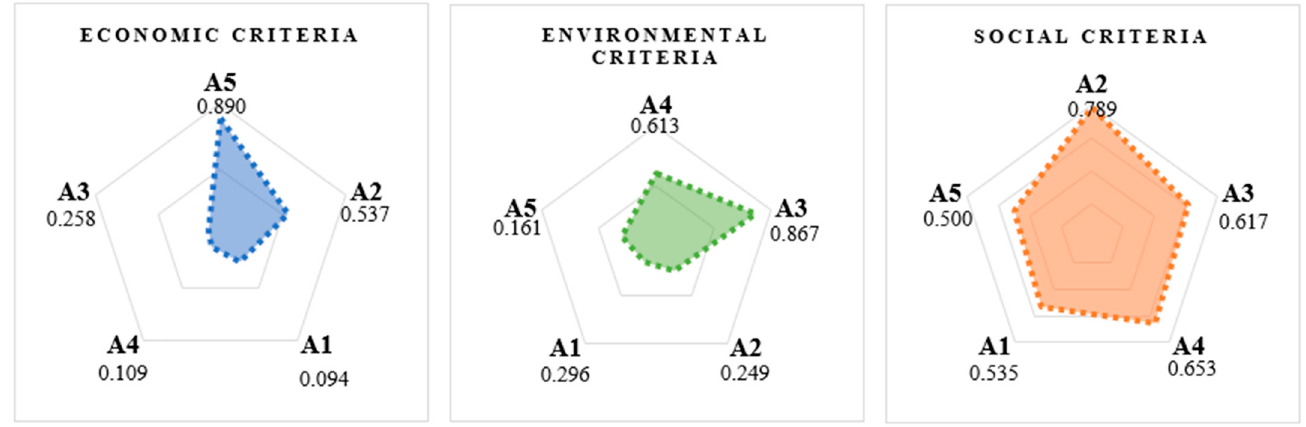
Figure 3. Results of the MARCOS method for different aspects of sustainability.